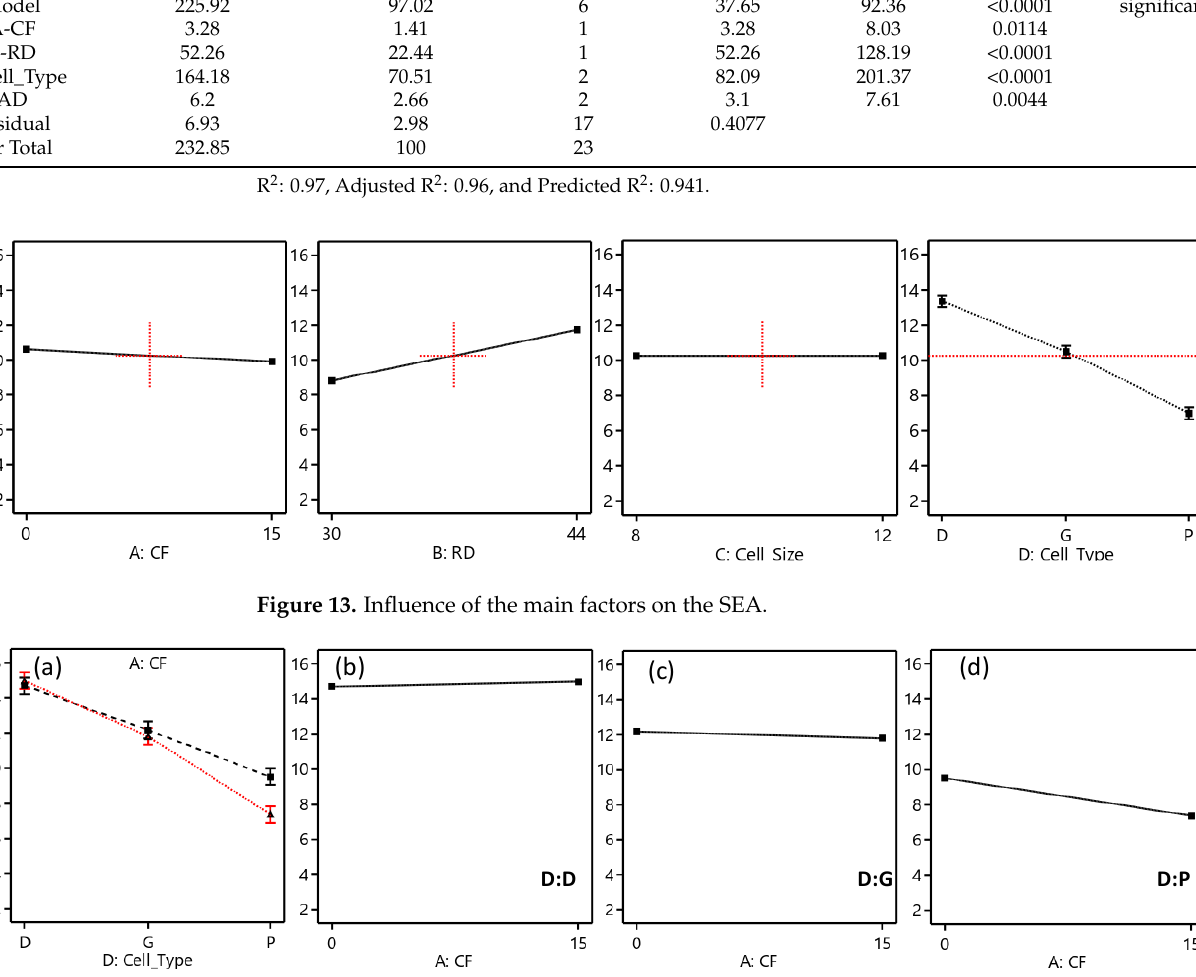
Figure 14. Varying impact of the CF % on the SEA based on cell type at a cell size of 12 mm and RD of 44%: ( a ) CF and cell type interaction, ( b ) Diamond cell type, ( c ) Gyroid Primitive cell type, and ( d ) Primitive cell type.